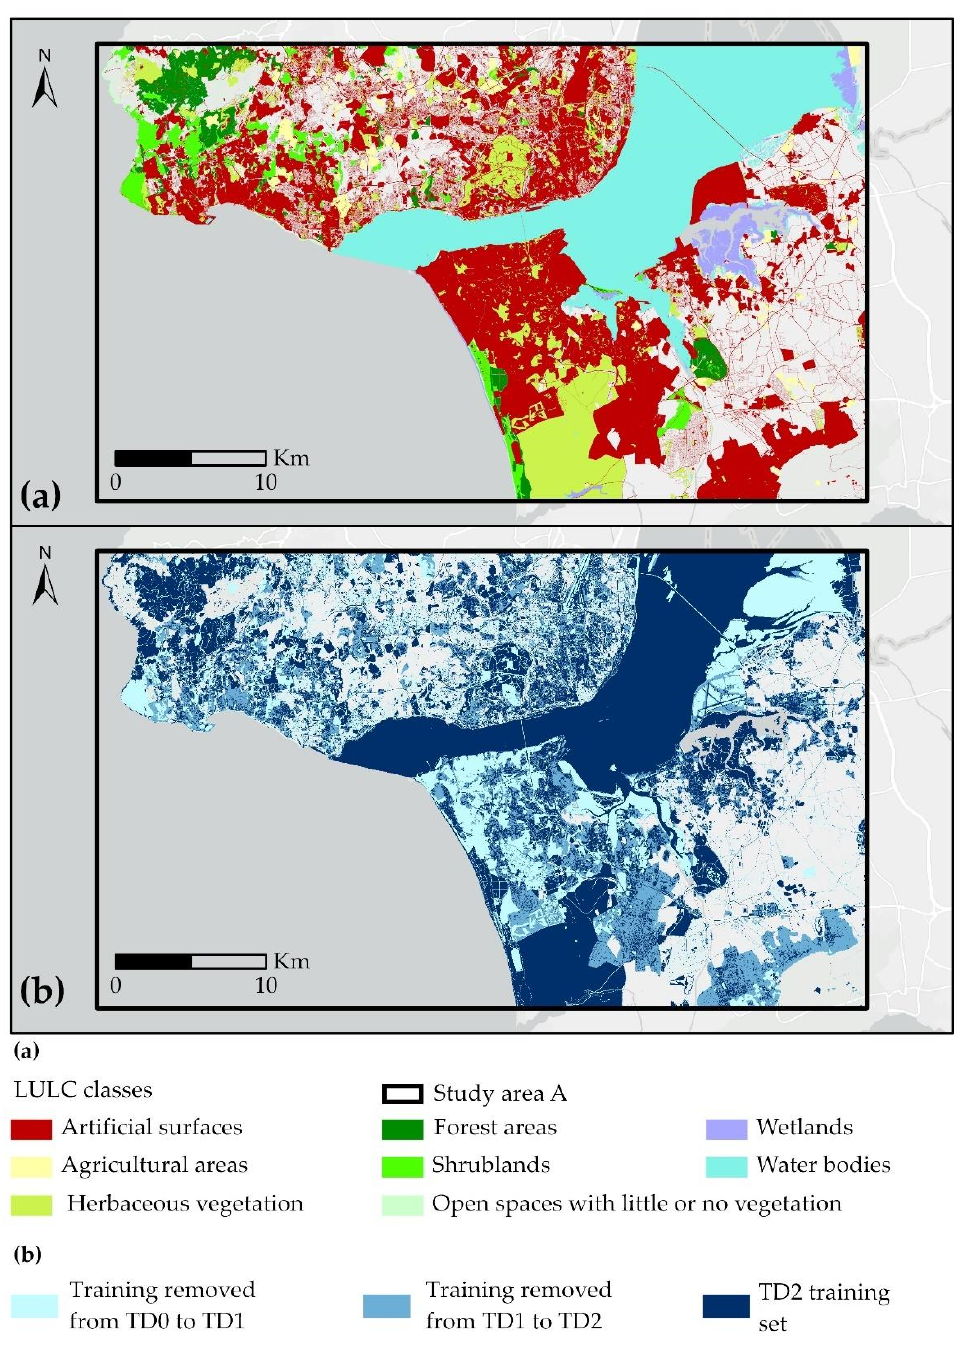
Figure 7. Training data for study area A: ( a ) Shows the TD0 training set. ( b ) Shows the regions excluded from TD0 to obtain TD1 (light blue) as well as the regions removed from TD1 to obtain TD2 (a medium shade of blue) and TD2 (dark blue).